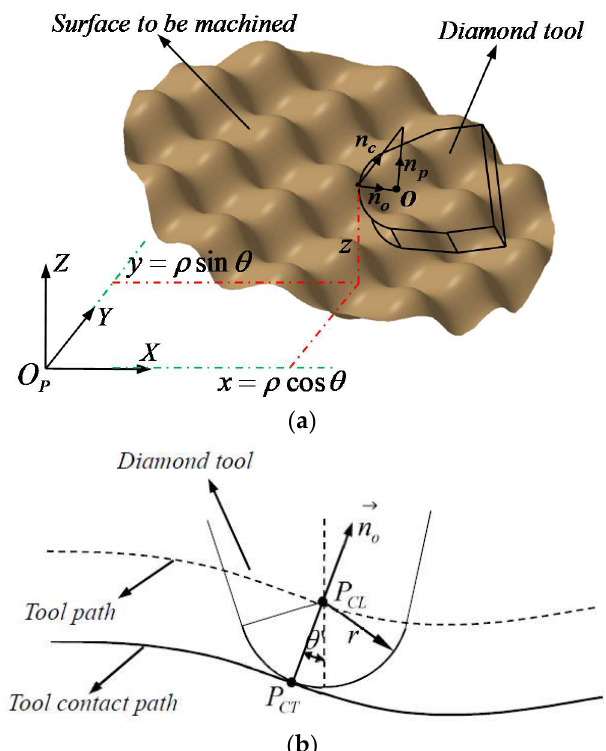
Figure 14. Tool nose radius compensation. ( a ) Tool nose radius compensation model; and ( b ) Tool nose radius compensation presented in detail.